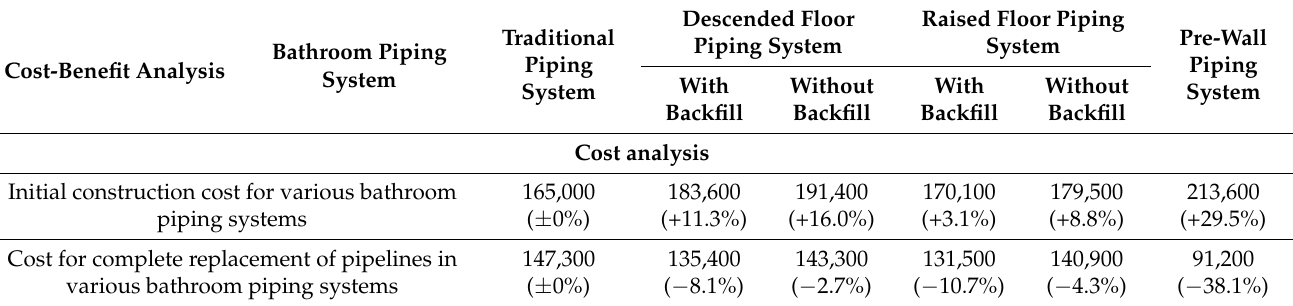
Table 4. Cost-benefit analysis of the four types of bathroom piping